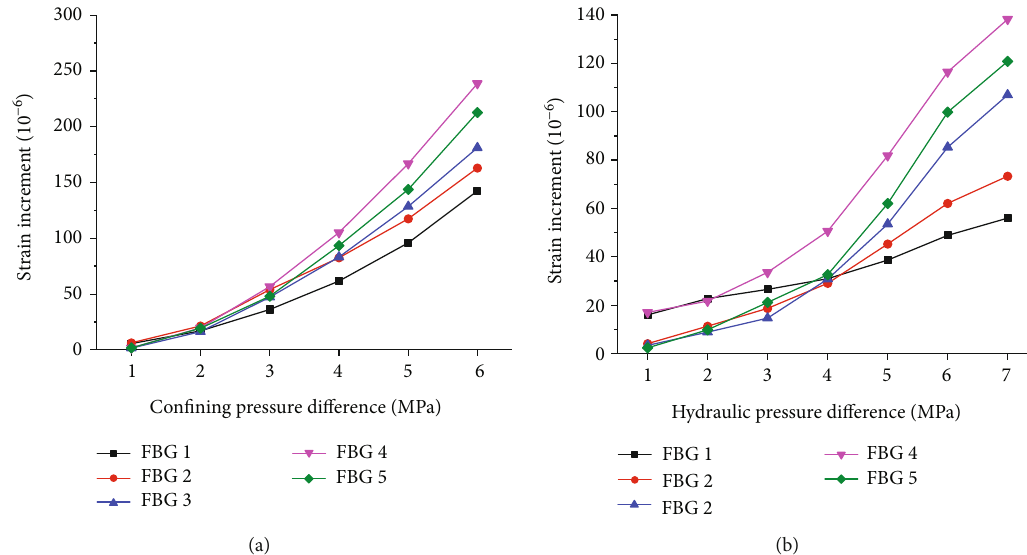
Figure 12: Strain monitoring results of microfracture surface with JRC = 0~2 : (a) relationship between strain measured at di ff erent points and con fi ning pressure di ff erence and (b) relationship between strain measured at di ff erent points and hydraulic pressure di ff erence.